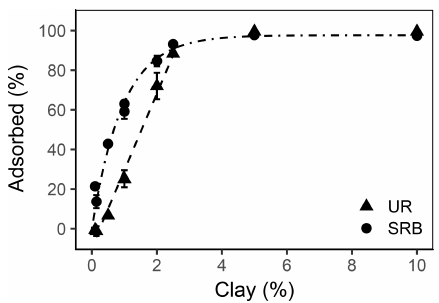
Figure 5. K d values as function of OC (%) for UR (triangles) and SRB (circles) in topsoil (filled symbols) and subsoil (open sym- bols). For each tracer and type of substrate (topsoil or subsoil) the K d value at a lower OC value results from the H 2 O 2 treatment. The error bars represent the standard errors of K d values from linear regression.